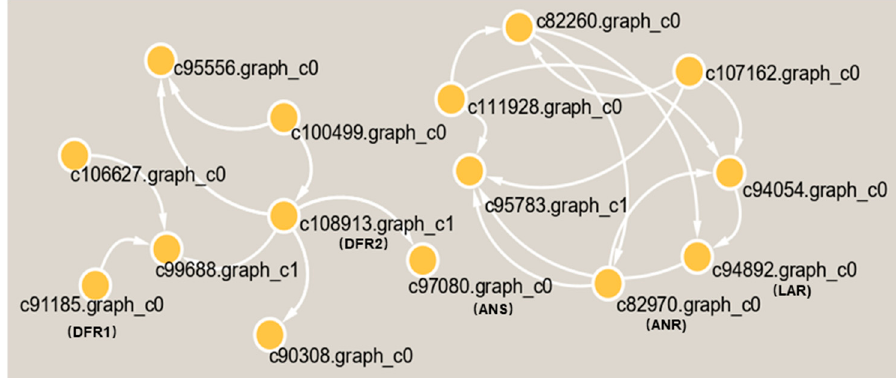
Figure 8. The interaction network of differential proteins in the metabolic pathway of PA in T. hemsleyanum.